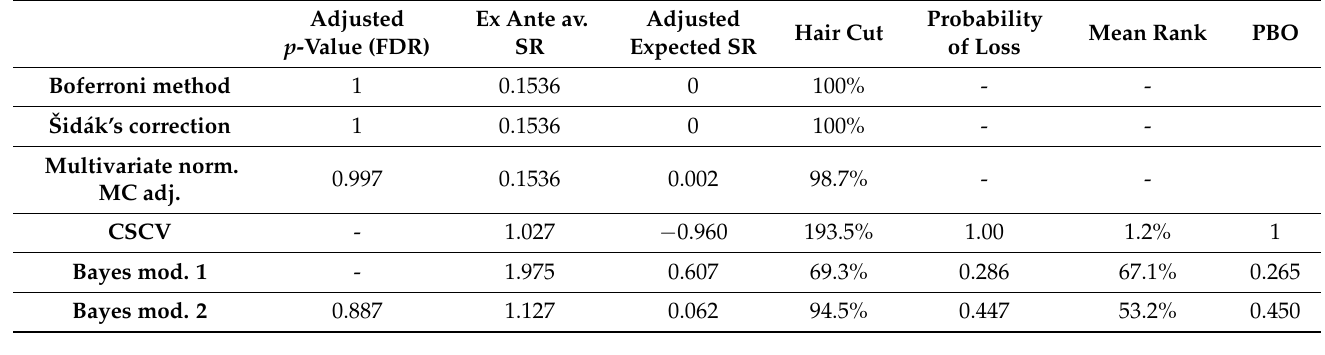
Table 3. Summary of the test results.